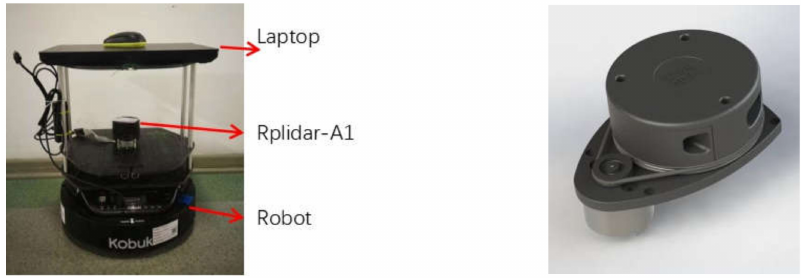
Figure 6. Experimental facilities, robot platform ( left ), RPLidar-A1 sensor ( right ).